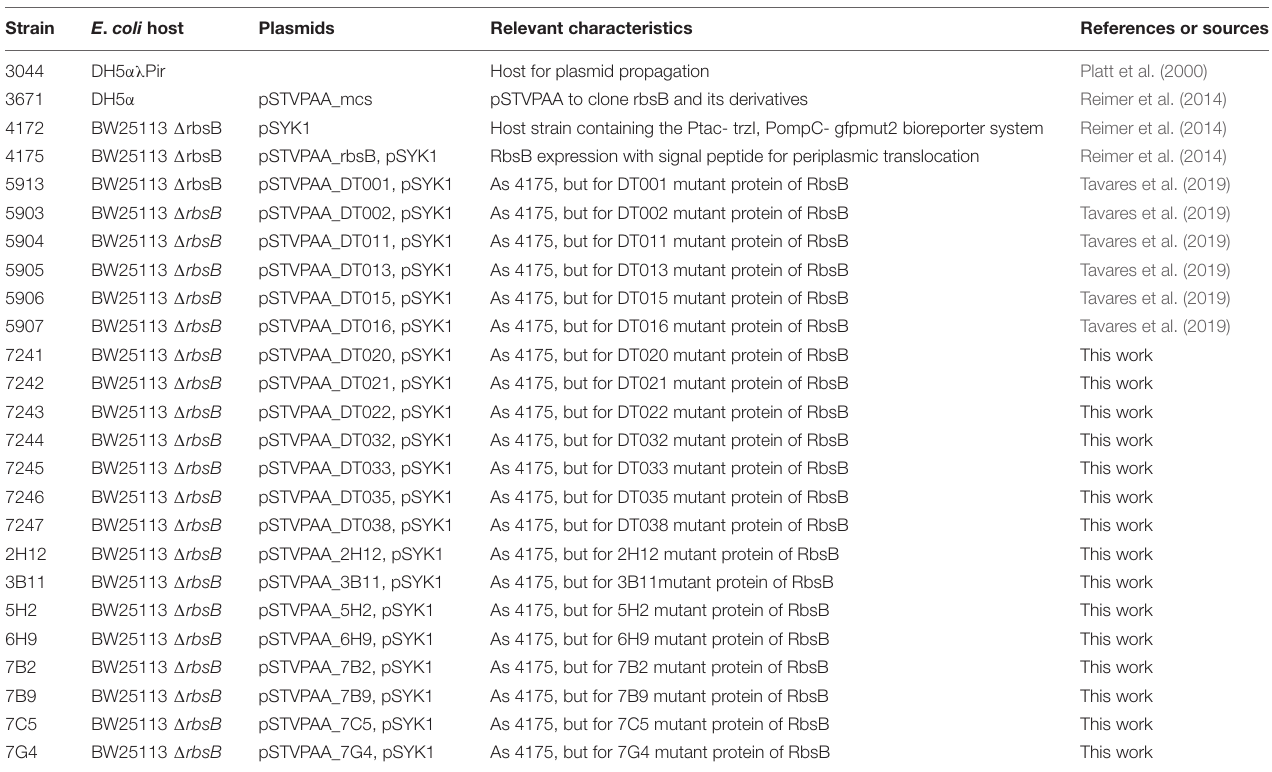
FIGURE 5 | Flanking residue mutagenesis. (A) Scheme of the design strategy to reconstitute dt016 with 12 overlapping primers (purple), positioned at the sites of the previous ligand binding pocket mutations, and each covering the two neighboring codons on each side. The assembly was carried out in three steps (fragments separated by dotted lines) and followed by a final extension reaction with external primers (orange). Gene not drawn to scale. (B) Inferred structure of DT016 based on RbsB structure (PDB ID: 2DRI). Molecular structure with 13CHD (red) bound in its pocket. The eight designed substitutions in DT016 are highlighted in orange and flanking residues mutated with this strategy are highlighted in green. TABLE 3 | Strains used in this